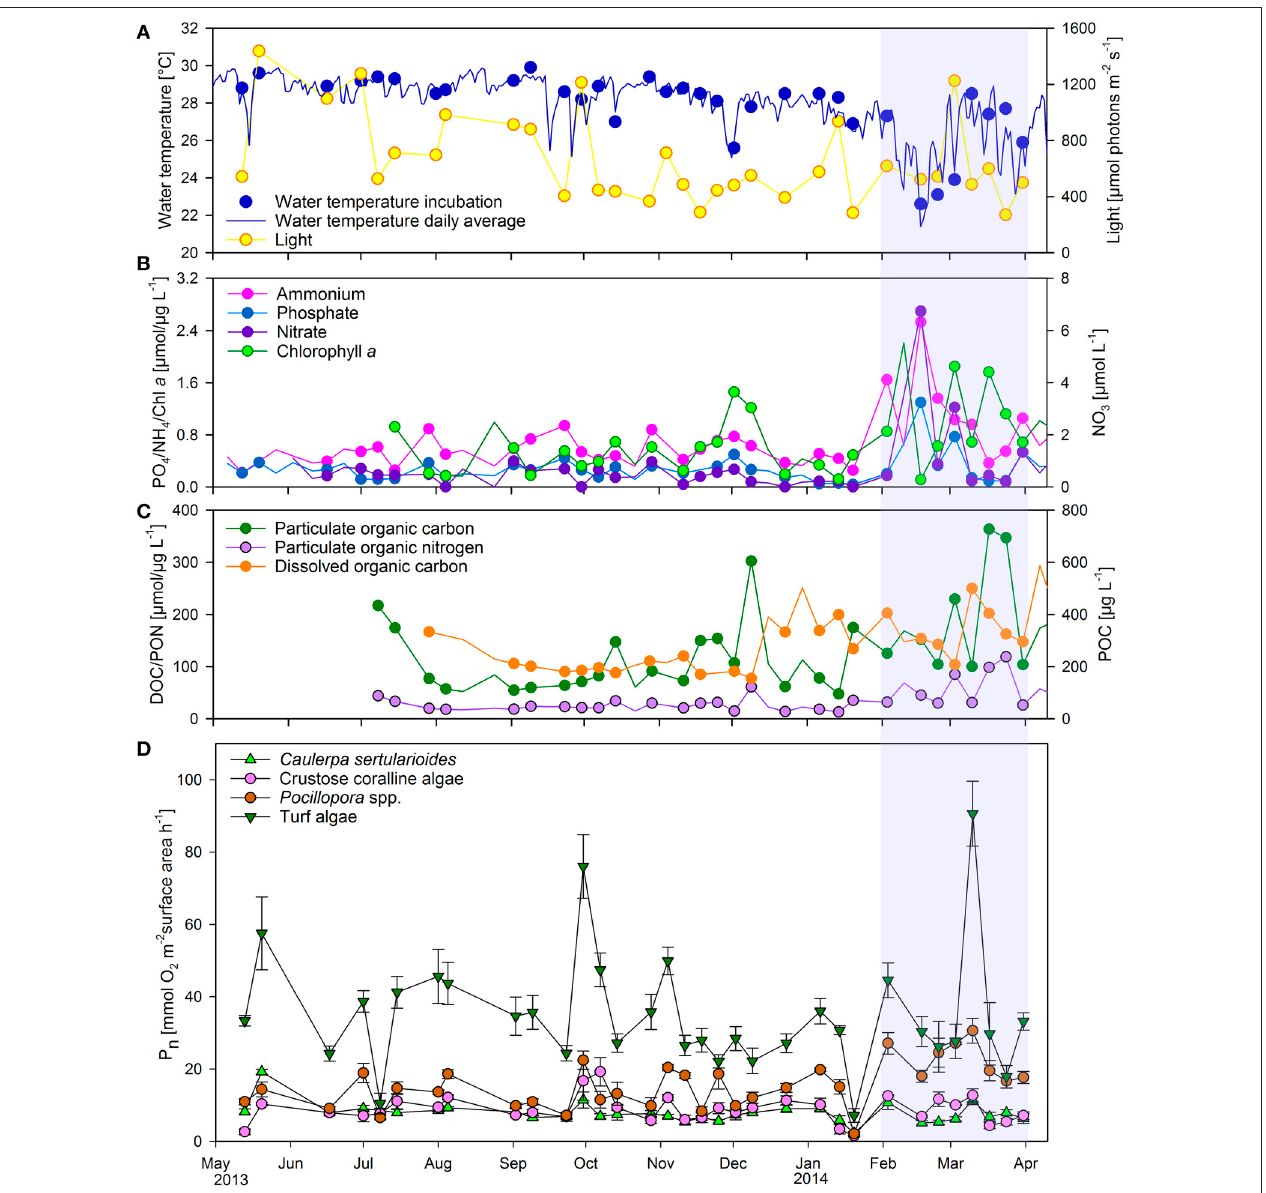
FIGURE 5 | Seasonal changes in water parameters and individual net primary production. (A) Water temperature and light availability in 5m water depth, (B) inorganic nutrient concentrations, (C) dissolved and particulate organic matter and (D) net primary production rates of main primary producers on the reef (mean ± SE). Lines in (A–C) display all available data points while scatter points indicate measurements parallel to incubations which were used for linear model fitting. PO 4 , phosphate;